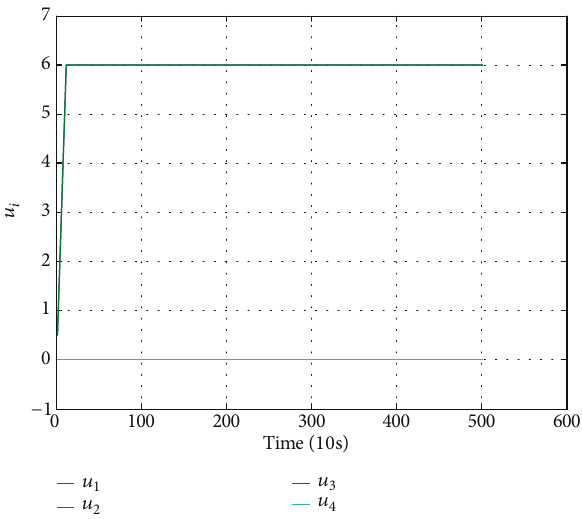
Figure 10: The variation curve of system input, when the load of generator unit is 400MW, 𝑢 𝑗 ∈ [0,7.5] , Δ𝑢 𝑗 = 0.5 .